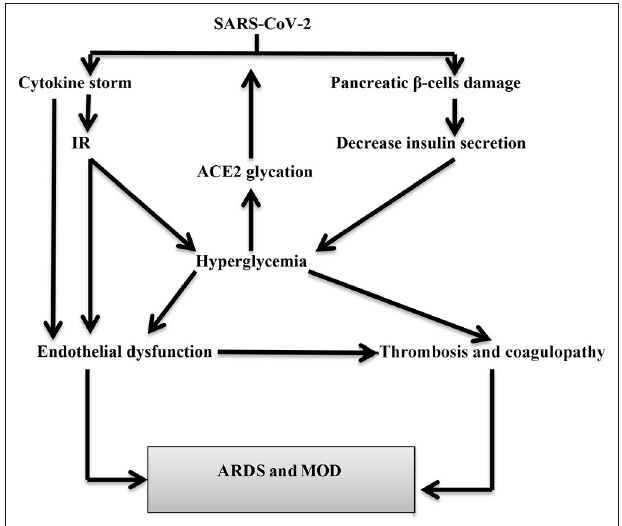
FIGURE 2 | SARS-CoV-2-induced hyperglycemia in COVID-19 patients. SARS-CoV-2 leads to hyperglycemia either directly through pancreatic β -cells injury or indirectly through cytokine storm-induced insulin resistance (IR). Hyperglycemia increased SARS-CoV-2 entry through glycation of ACE2. Hyperglycemia may cause acute respiratory distress syndrome (ARDS) and multiorgan damage (MOD) through the induction of endothelial dysfunction and coagulopathy.